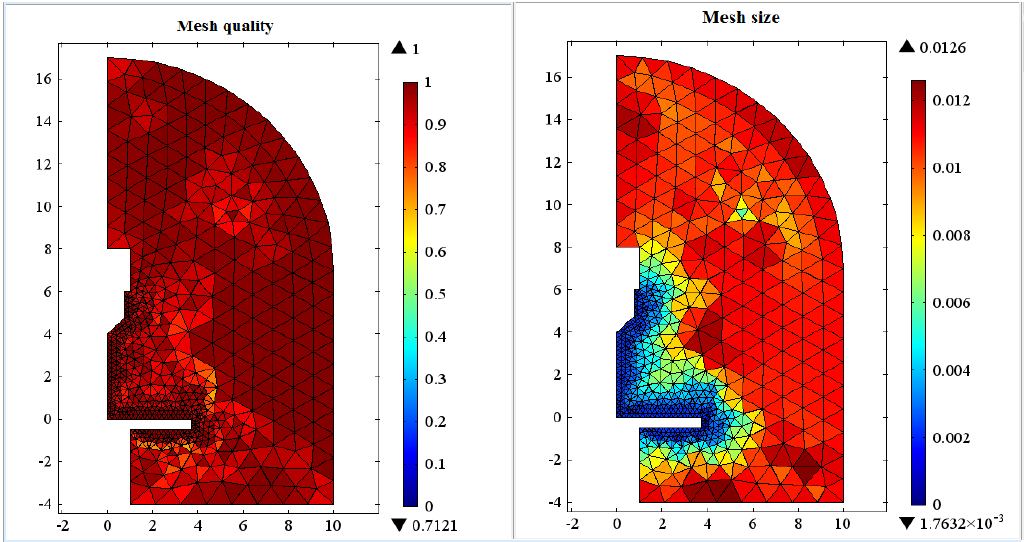
Fig.3: Experience of mesh quality and